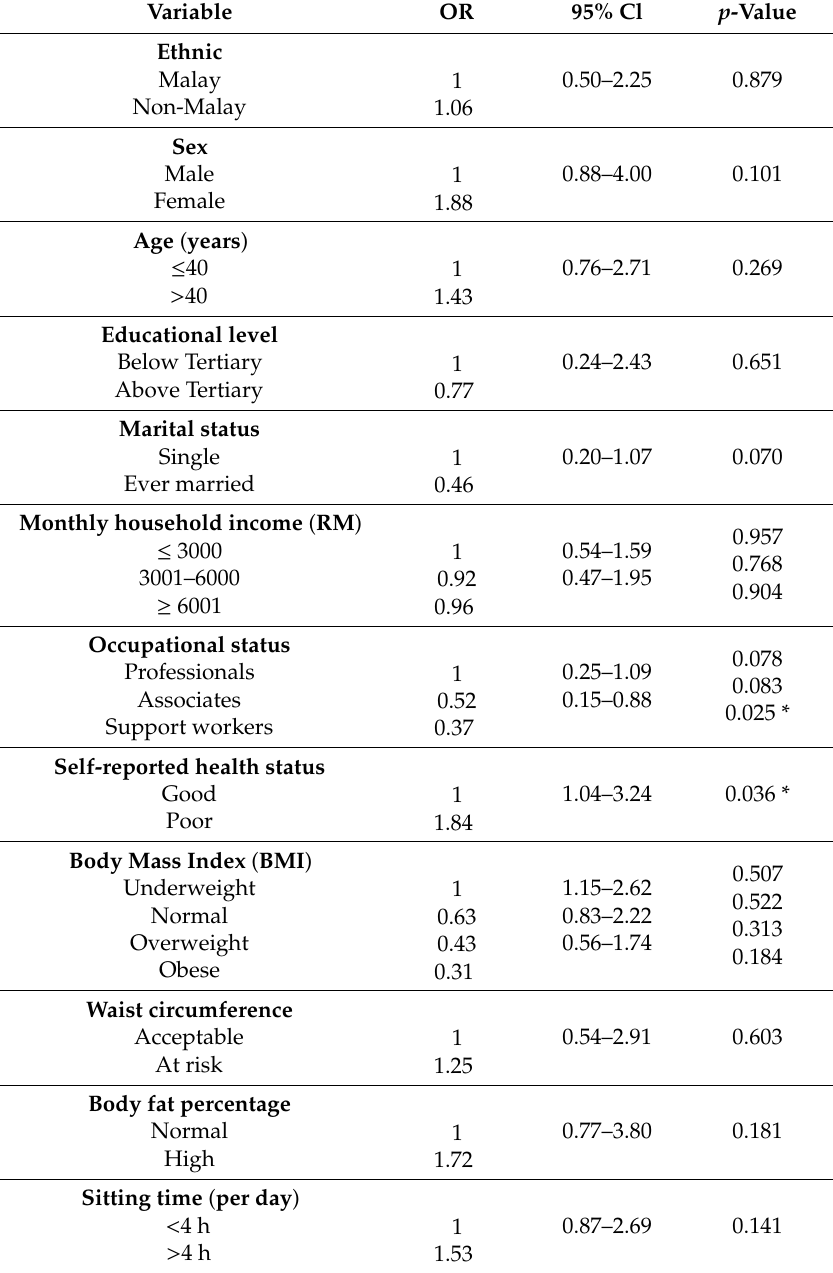
Table 4. Logistic regression analysis of various variables associated with physical activity level among the primary healthcare